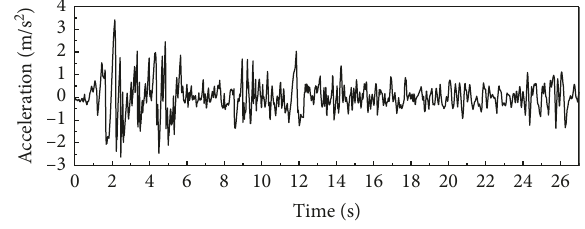
Figure 3: Corrected date of the seismic wave.